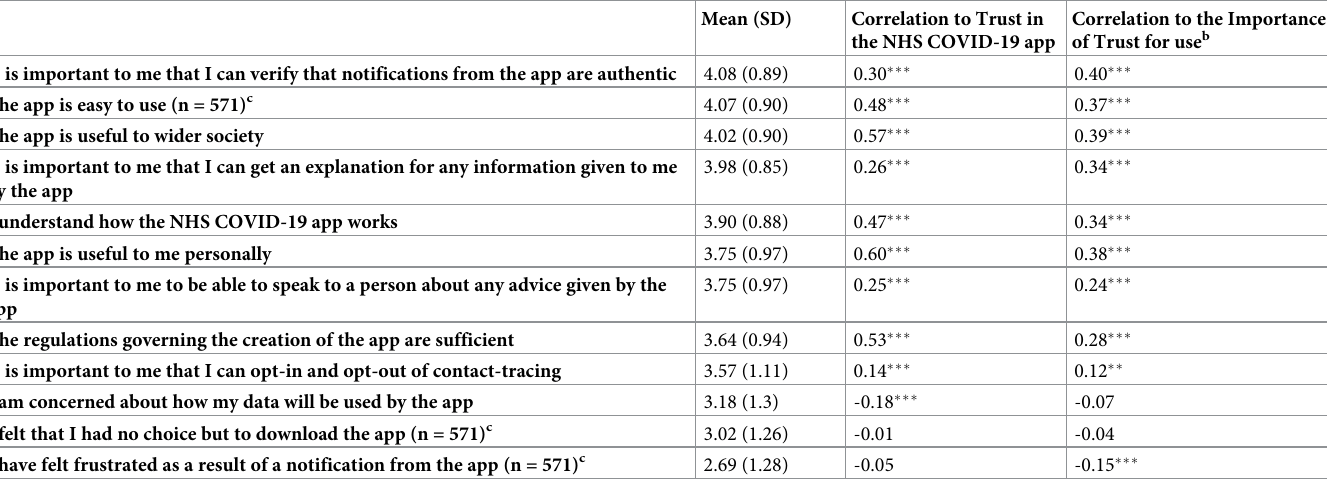
Table 5. Agreement with statements related to the technology and ecosystem surrounding the NHS COVID-19 app a , and their relationship with trust in the app b .